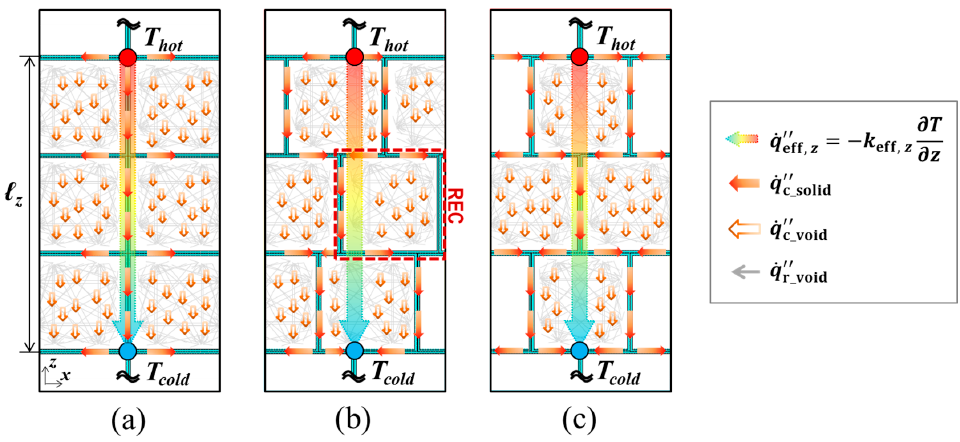
Figure 3. Tortuosity of the solid skeleton: ( a ) outermost inline, ( b ) in-between, and ( c ) outermost staggered formations.